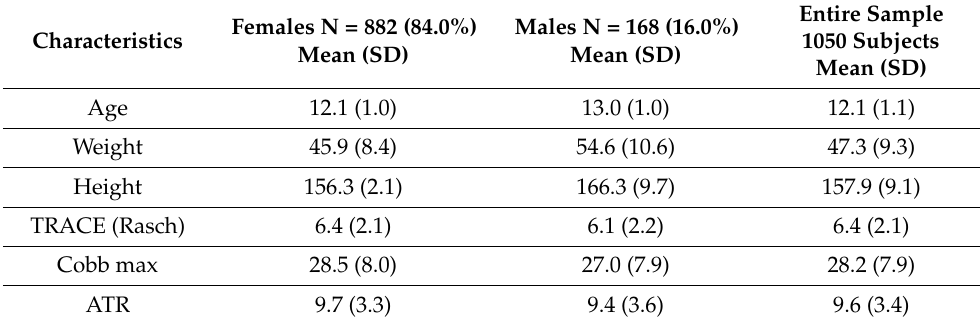
Table 1. Baseline characteristics of the subjects included.